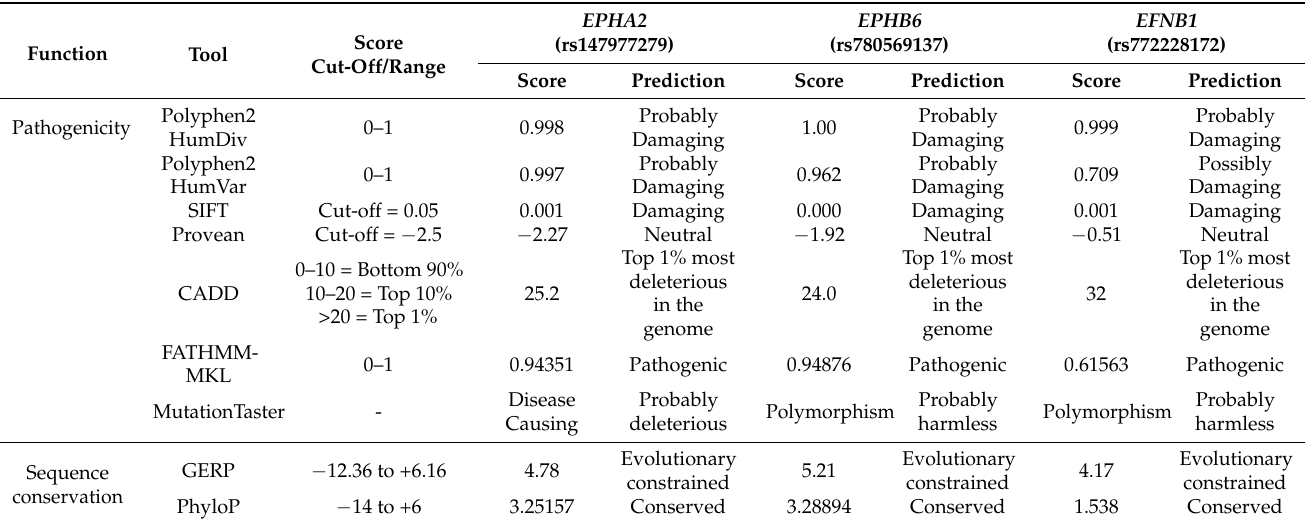
Table 4. Predictions of pathogenicity potential and sequence conservation analysis of Eph and ephrin candidate variants.